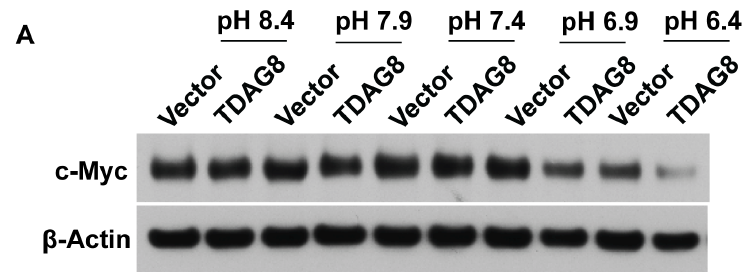
Figure 4. TDAG8 induced c-Myc protein downregulation is pH dependent. ( A )